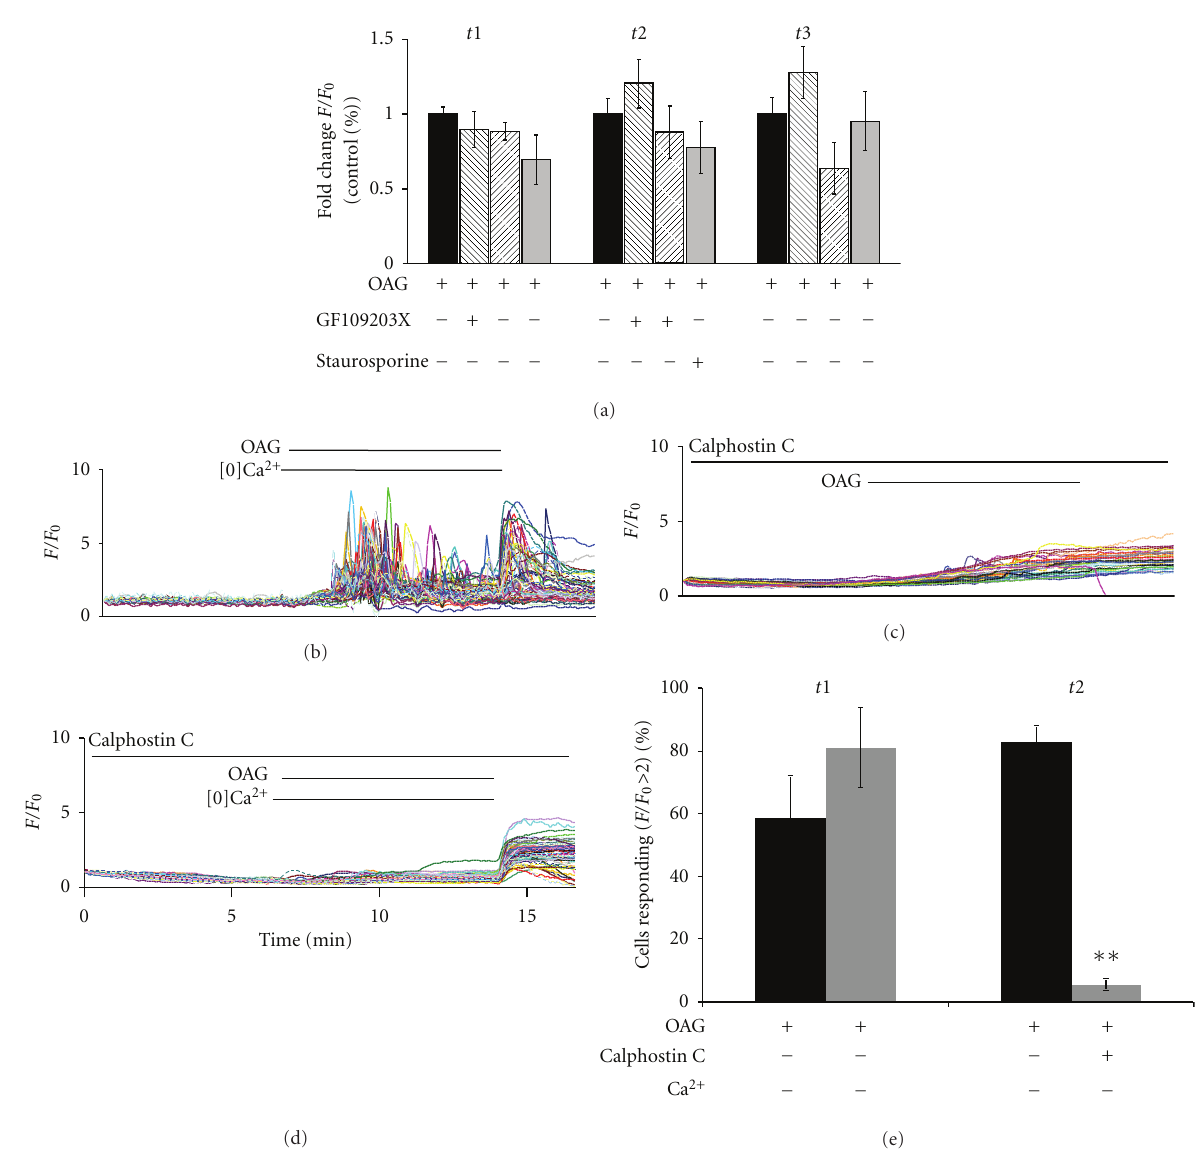
Figure 4: PKC activation is not necessary for OAG-induced release of ATP from astrocytes. (a) Adding 1 µ M GF 109203X (GFX) during the second imaging period does not reduce calcium oscillations ( P = 0 . 3, control n = 8, GFX n = 5) in response to 100 µ M OAG. Pretreating astrocytes with 1 µ M GFX and including GFX during t 1 and t 2 does not reduce calcium oscillations induced by 100 µ M OAG ( P = 0 . 14, control n = 8, GFX = 5), although there is a significant ( P = 0 . 03) increase in calcium oscillations after washout in this GFX condition. The serine/threonine kinase inhibitor staurosporine does not have an e ff ect on calcium oscillations induced by 100 µ M OAG when added during t 2 ( P = 0 . 36, control n = 7, staurosporine n = 4). (b) Astrocytes display robust OAG-induced calcium oscillations in nominally calcium-free external solution. (c) Incubation with 100nM Calphostin C during a 15-minute light activation period followed by incubation during t 2 abolished calcium oscillation and induced a slow increase in Fluo4 signal during the OAG incubation. (d) The slow increase in Fluo4 signal is abolished in the absence of external calcium and oscillations are absent in the presence of 100 nM Calphostin C and 30 µ M OAG. (e) Calcium oscillations in nominally calcium-free medium induced by 30 µ M OAG are significantly reduced by the addition of 100 nM Calphostin C ( P = 0 . 004, control n = 5, calphostin C n = 4). As calphostin C is irreversible, there is no washout period ( t 3) for